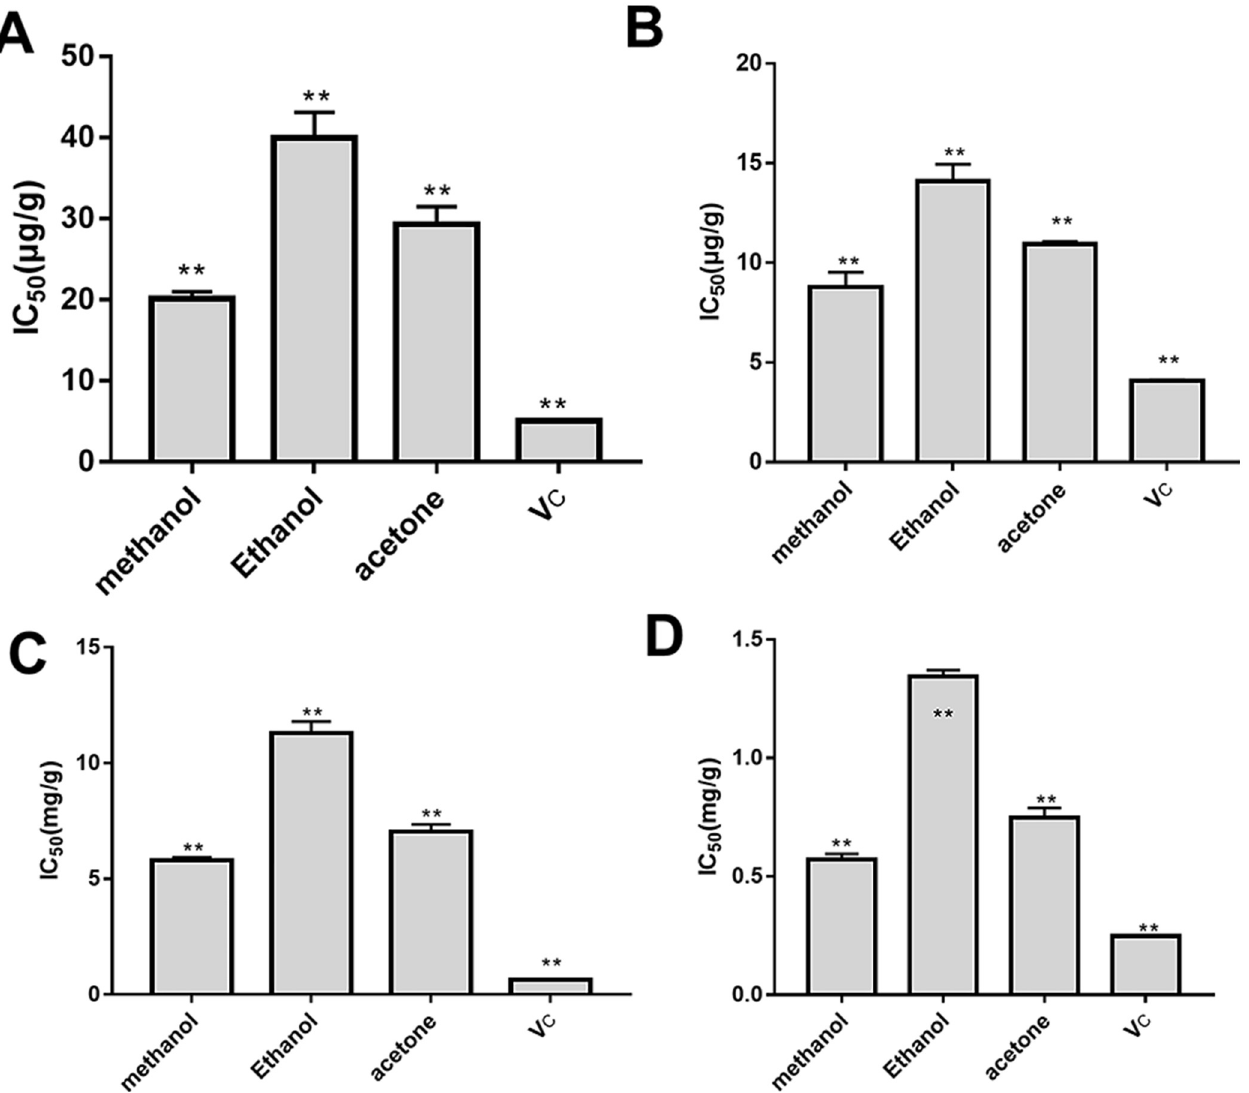
Fig 2. IC 50 values (mg/mL) of different extracts on free radicals. Comparison of IC 50 values using methanol, ethanol, acetone, and Vc for extraction and scavenging of (A) DPPH radical, (B) ABTS radical, (C) hydroxyl radical, and (D) superoxide anion radical. �� P < 0.05.